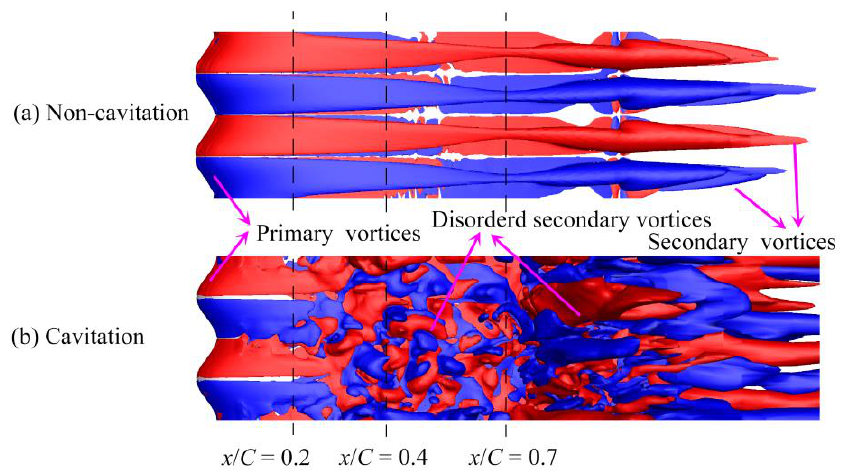
Figure 11. Flow structures visualized by iso-surfaces with constant value Q = 2 × 10 4 s − 2 (colored by velocity): ( a ) baseline ( b ) Type I.